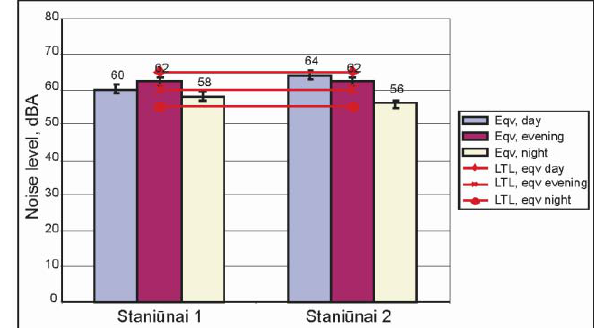
Fig. 24. Dynamics of equivalent noise levels in Staniūnai street within twenty four hours